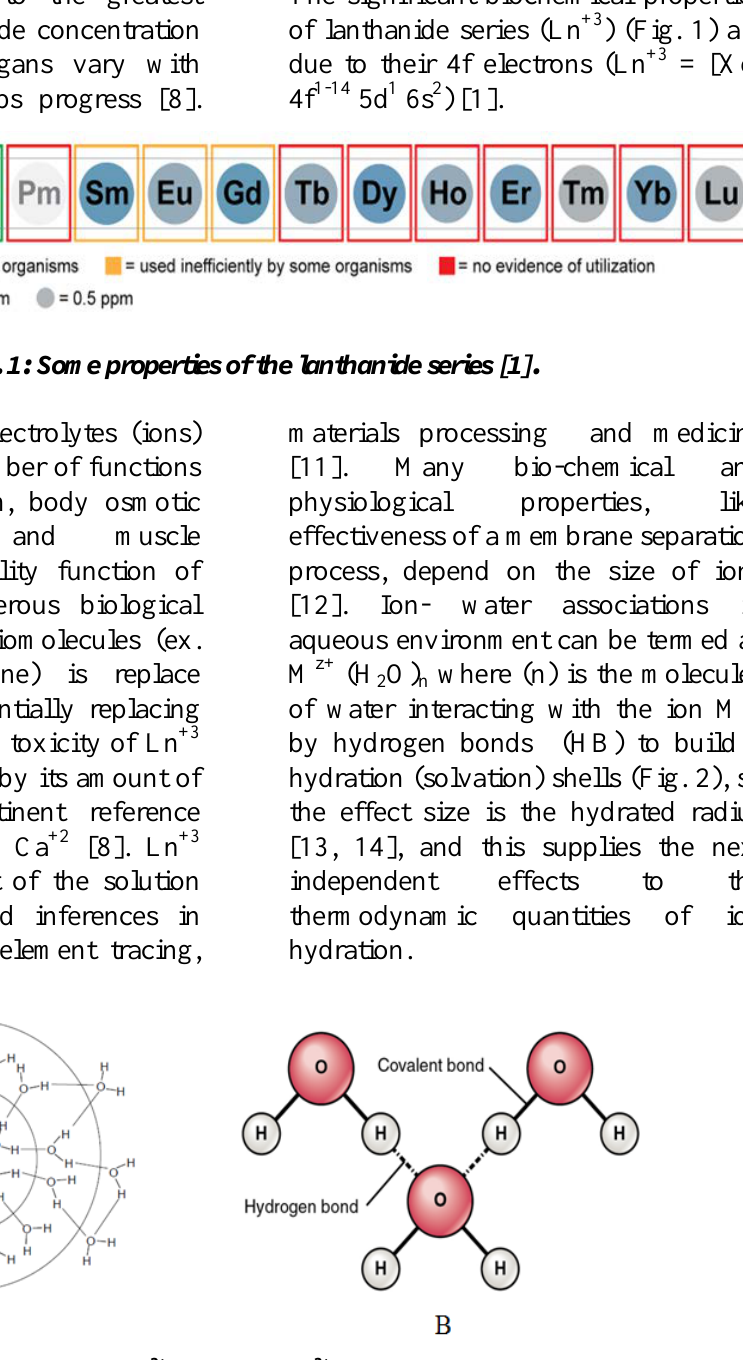
Fig. 2: A- The solvation shells of M 3+ ion (e.g. M 3+ of group 3) in water solution [15], B- Hydrogen bonds between water